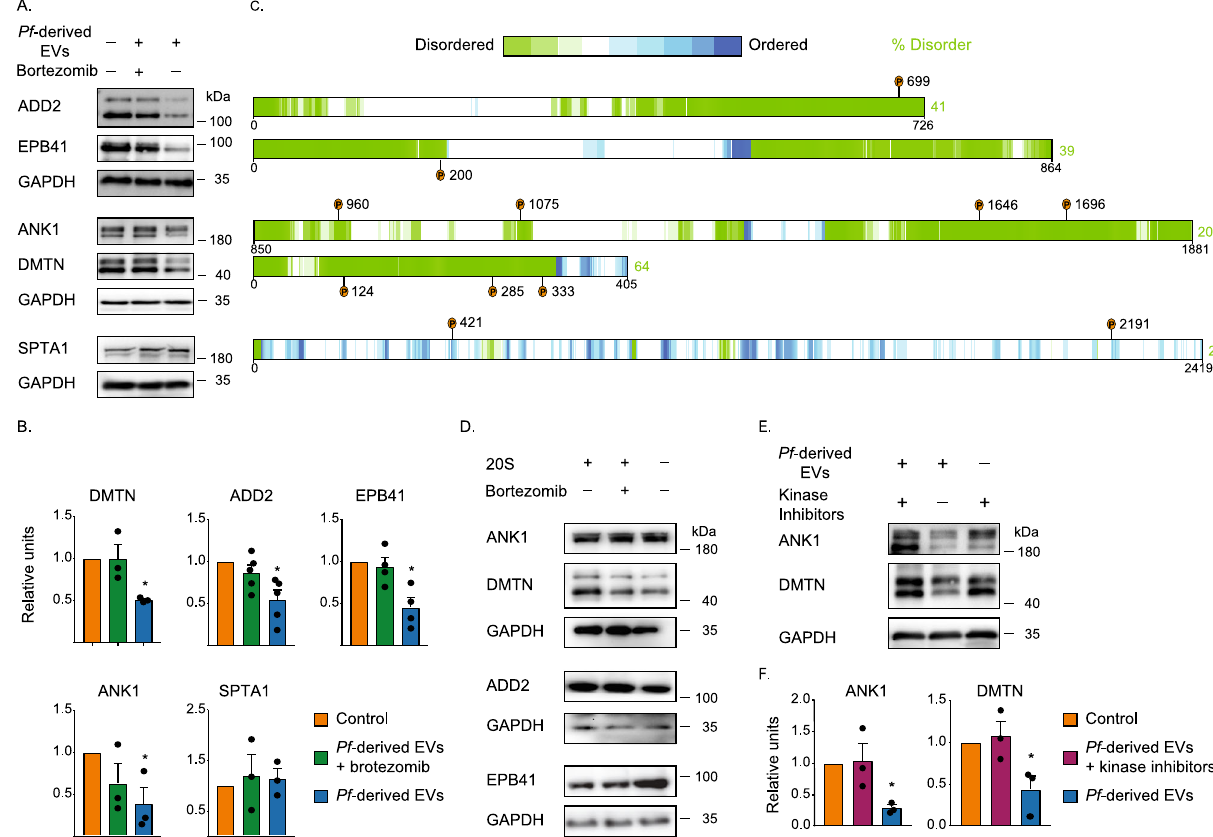
Fig. 5 RBC cytoskeleton proteins are target substrates of the EV-20S proteasome. A Degradation of cytoskeletal proteins following Pf -derived EV treatment. Western blot analysis of naïve RBCs treated with Pf -derived EVs in the presence or absence of the proteasome inhibitor bortezomib. Commercial antibodies were used against fi ve cytoskeletal proteins: β -adducin (ADD2), erythrocyte membrane protein band 4.1 (EPB4.1), ankyrin-1 (ANK1), dematin (DMTN), and spectrin α − chain (SPTA1). For each gel, GAPDH was used as a loading control. B Quanti fi cation and averaging of three independent experiments (as in A ). Each protein ’ s value was divided by the control value for that batch, thus creating a pair of ratios for each batch. The ratios of Pf -derived EVs were tested against the ratios of the Pf -derived EVs + bortezomib using a paired two-way t -test, error bars represent SD (DMTN * p = 0.0102, ADD2 * p = 0.01339, EPB41 * p = 0.02769, ANK * p = 0.01339). C Graphical illustration of the disorder prediction of human β -adducin, Ebp4.1, ankyrin-1, dematin, and spectrin α − chain, generated by D 2 P 2 (website: http://d2p2.pro), a database of protein disorder predictions. The level of disorder prediction is shown as a color intensity in which green segments represent disordered regions. The position of the unique phosphosites following treatment with Pf -derived EVs is indicated by orange circles. D Degradation assay of ghost naïve RBCs with puri fi ed 20S proteasome complexes. Bortezomib was used as a control for 20S proteasome inhibition. Panels display immunoblots using the relevant antibodies. Results represent three independent experiments (Supplementary Fig. S16). E Degradation of cytoskeletal proteins following Pf -derived EV treatment in the presence of kinase inhibitors mixture. Western blot analysis for naïve RBCs that were treated with Pf -derived EVs in the presence or absence of kinase inhibitor mixture (staurosporine and dihydrochloride). Antibodies were used against ankyrin-1 and dematin. GAPDH was used as a loading control (Supplementary Fig. S17). F Quanti fi cation and averaging of three independent experiments (as in E ), using a paired two-way t -test, error bars represent SD (ANK * p = 0.0421, DMTN * p = 0.0402). Source data for A and D are provided in the source data fi le. Source data for B and F are provided in Supplementary Fig.